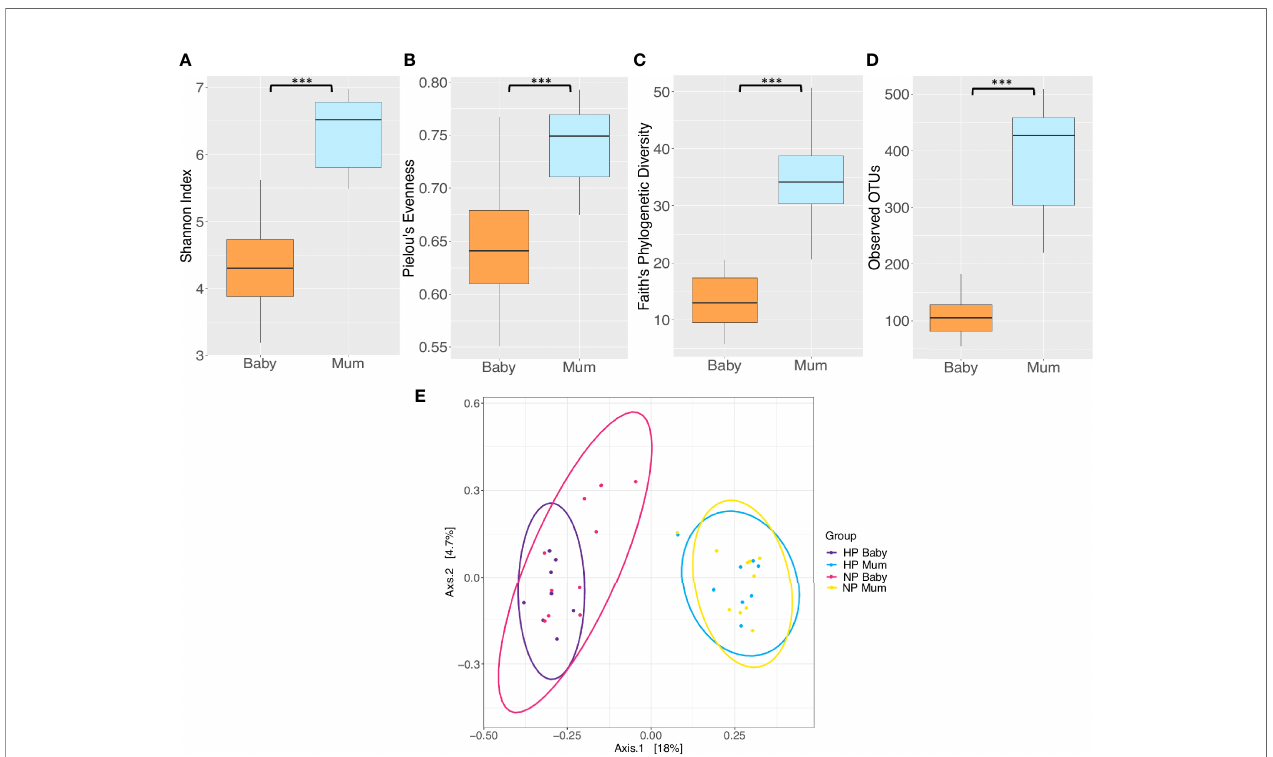
FIGURE 2 | Comparison of microbiota diversity between mothers ( n = 18) and their babies ( n = 18) based on faecal samples collected at 6 months postpartum and at six months of age respectively. Alpha diversity measured by (A) Shannon index (B) Pielou ’ s evenness (C) Faith ’ s phylogenetic diversity (D) Observed operational taxonomic units (OTUs). Boxes represent the interquartile range (IQR), the line inside the box indicates the median and whiskers represent values 1.5 × IQR from the fi rst and third quartiles respectively. Differences between mothers and babies were tested using the Wilcoxon sum rank test and false discovery rate (FDR) corrected. *** P < 0.001. (E) Principal Coordinates Analysis (PCoA) of microbiota community structure in mothers and babies. NP, normotensive pregnancy; HP, hypertensive pregnancy. The points represent individual samples from mothers and their babies, and the ellipses illustrates the 95% con fi dence intervals of multivariate normal